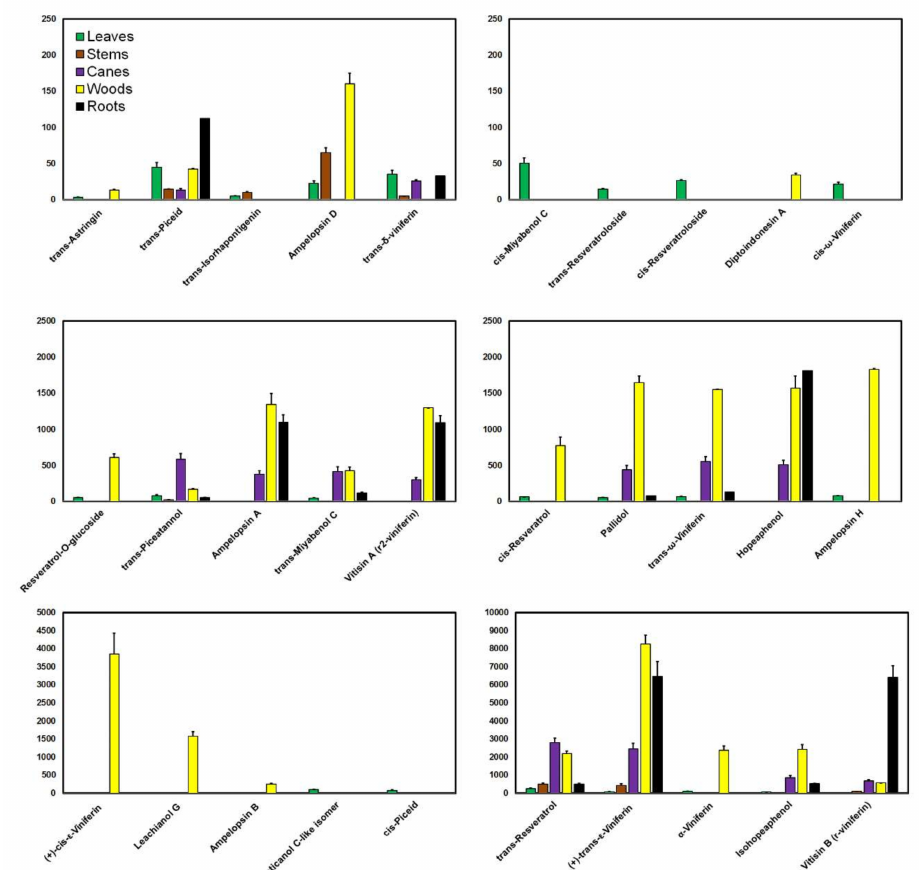
Figure 2. Distribution of the major stilbenic compounds in the vegetative organs of the vine plant: mean values ( y -axis; mg / kg) + standard deviations as error bars divided by 10 for better